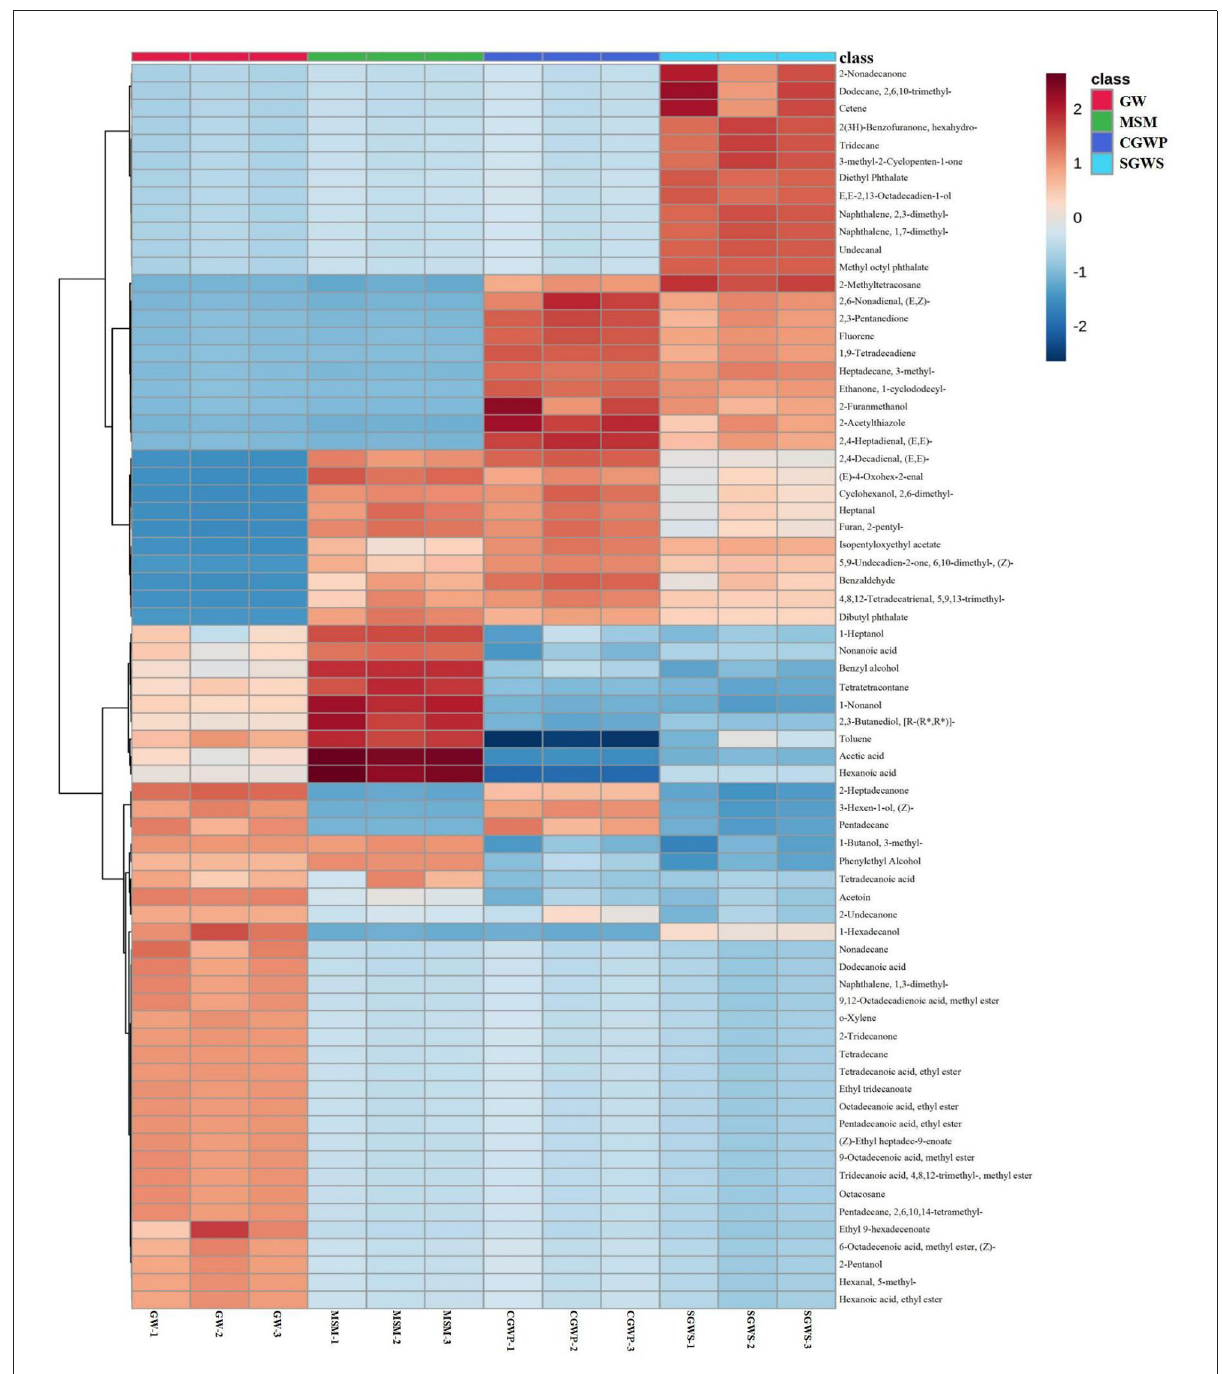
FIGURE5 Clustering heatmap of the concentration of volatile compounds in nian zhuan at each processing stage.